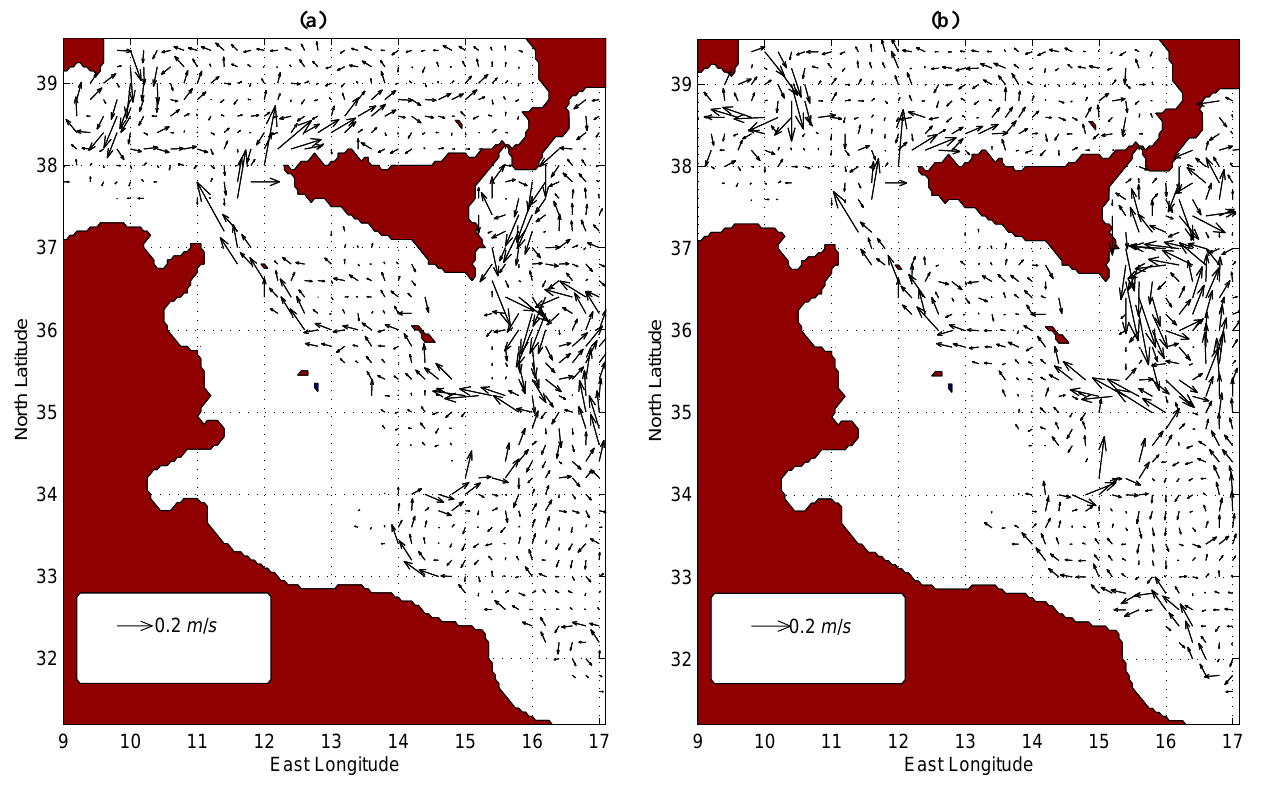
Fig. 19. The simulated 10-day averaged total velocity field at 280m depth in (a) February and (b) August. One vector every four grid points is plotted. Units are